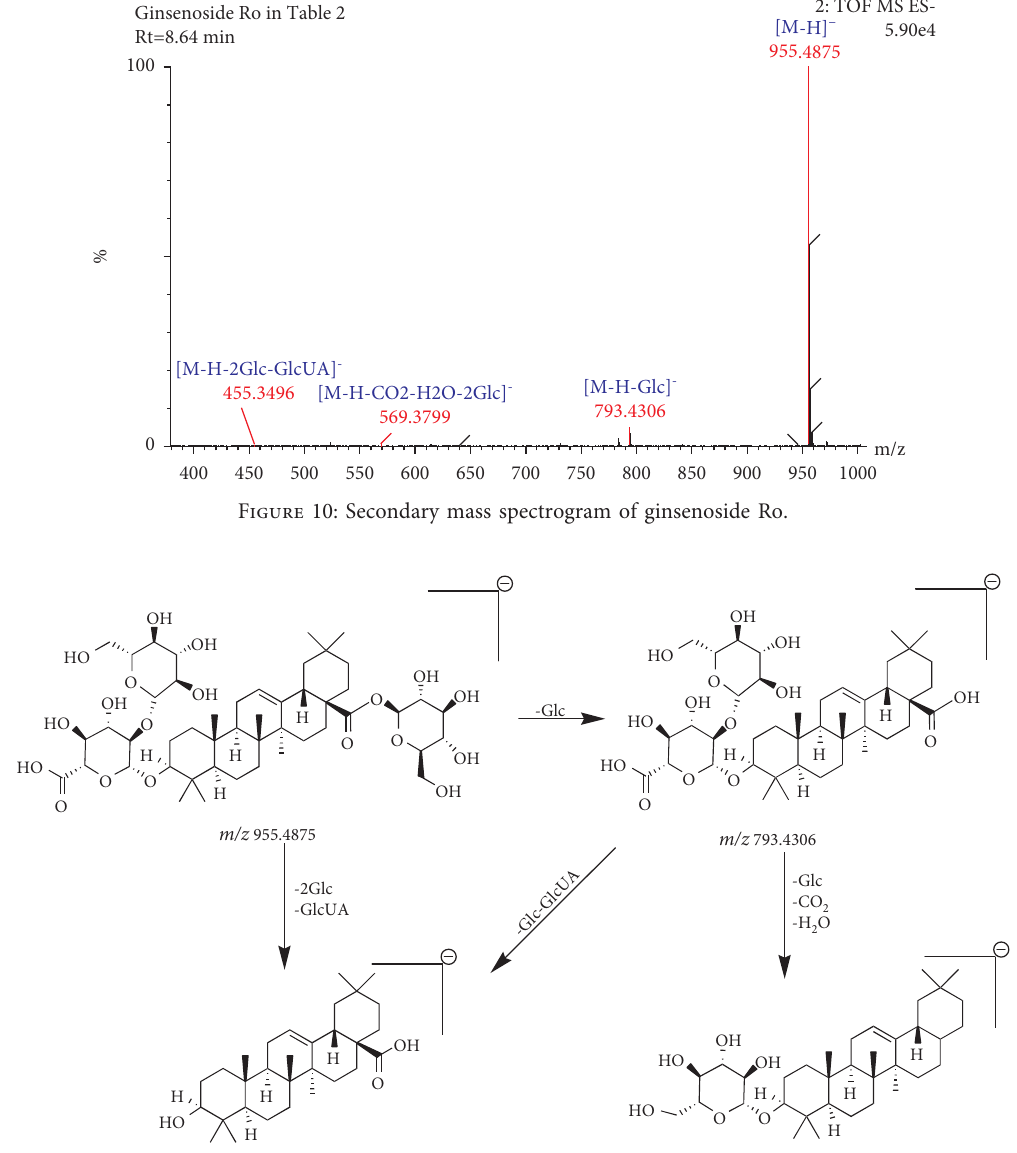
Figure 11: The fragmentation pathway of ginsenoside Ro.